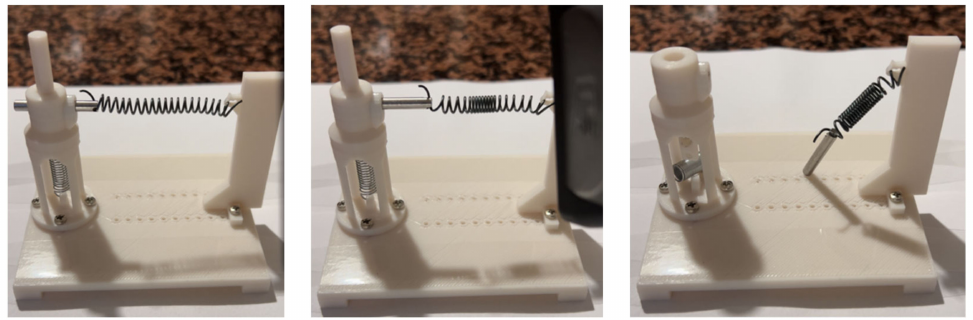
Figure 11. EBB triggering sequence.